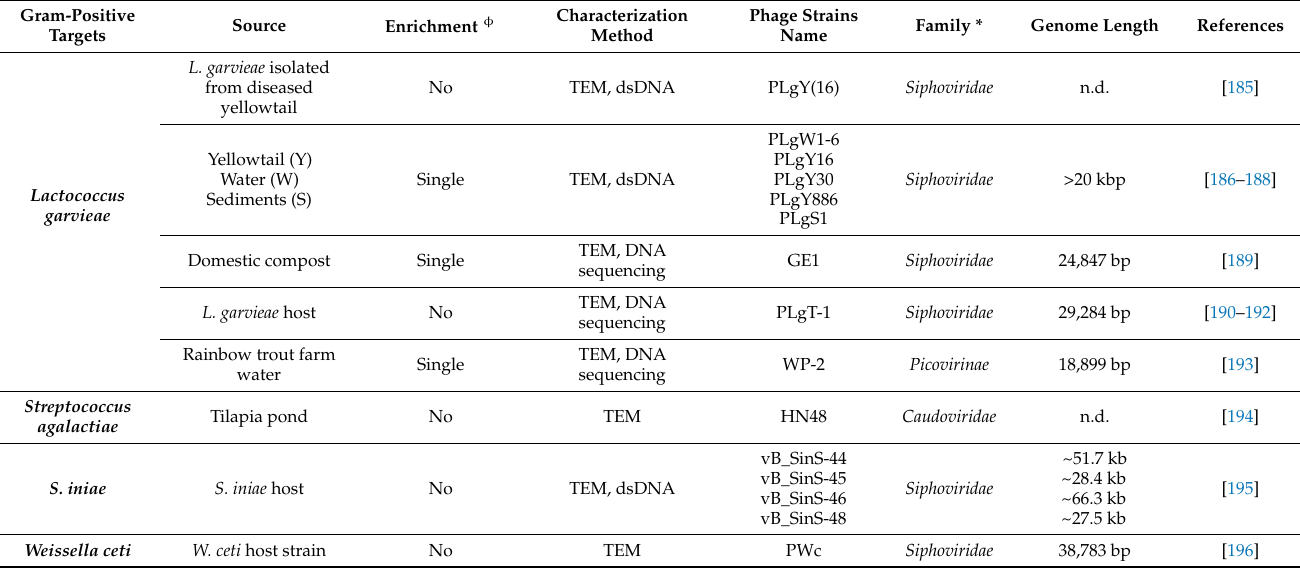
Table 2. Phages used against Gram-positive bacterial fish and shellfish